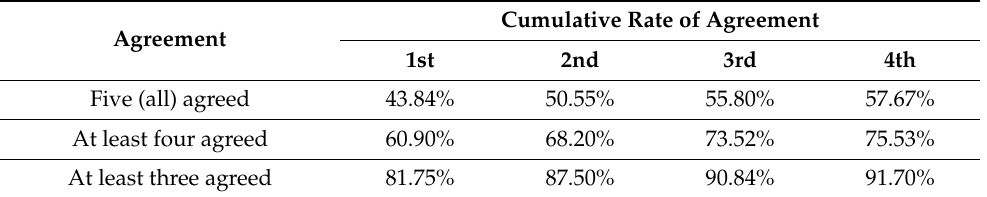
Table 4. Inter-transcriber agreement in tagging prosodic break with tone.